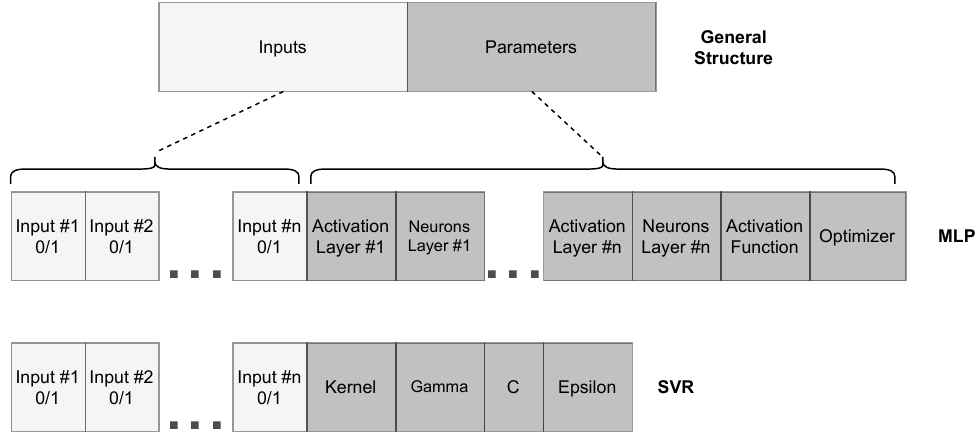
Figure 3. Chromossome of the individuals of the proposed